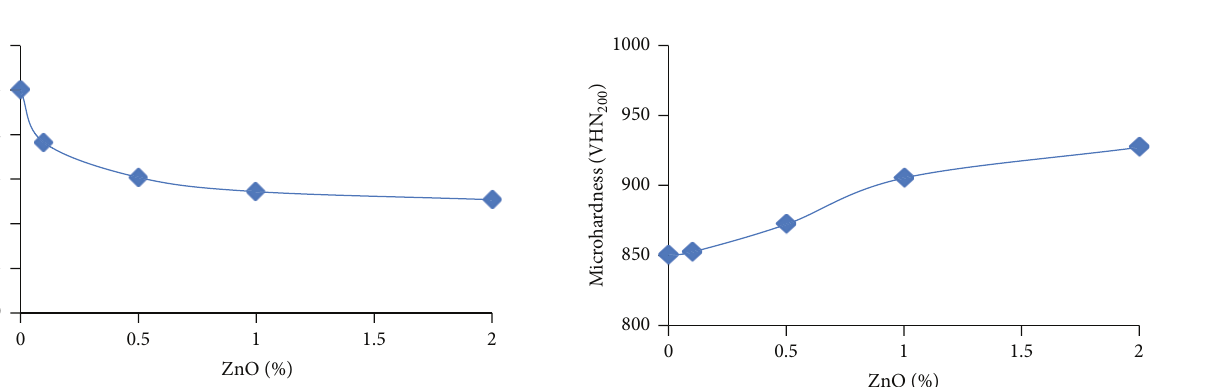
Figure 14: Variation in microhardness of EN-coatings as a function of ZnO with surfactant (SLS) in EN bath.